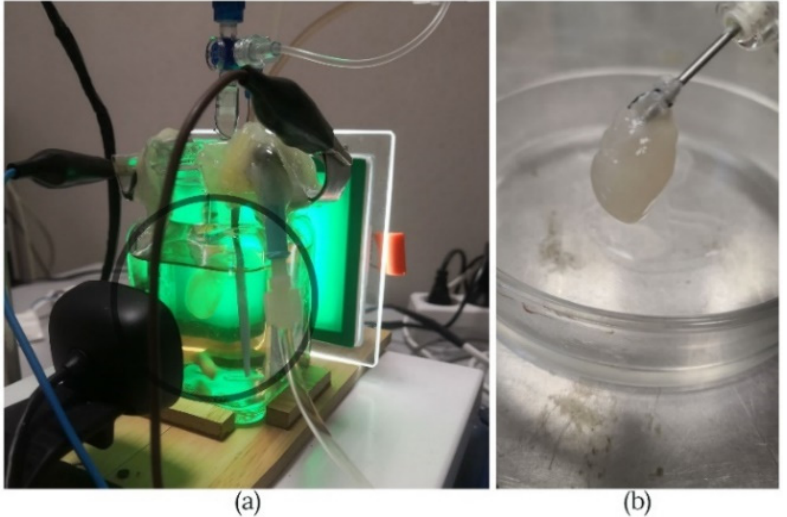
Figure 7 . ( a ) Rat heart floating in decellularization solution in the perfusion chamber (black circle). ( b ) The macroscopic aspect of the rat heart ECM.